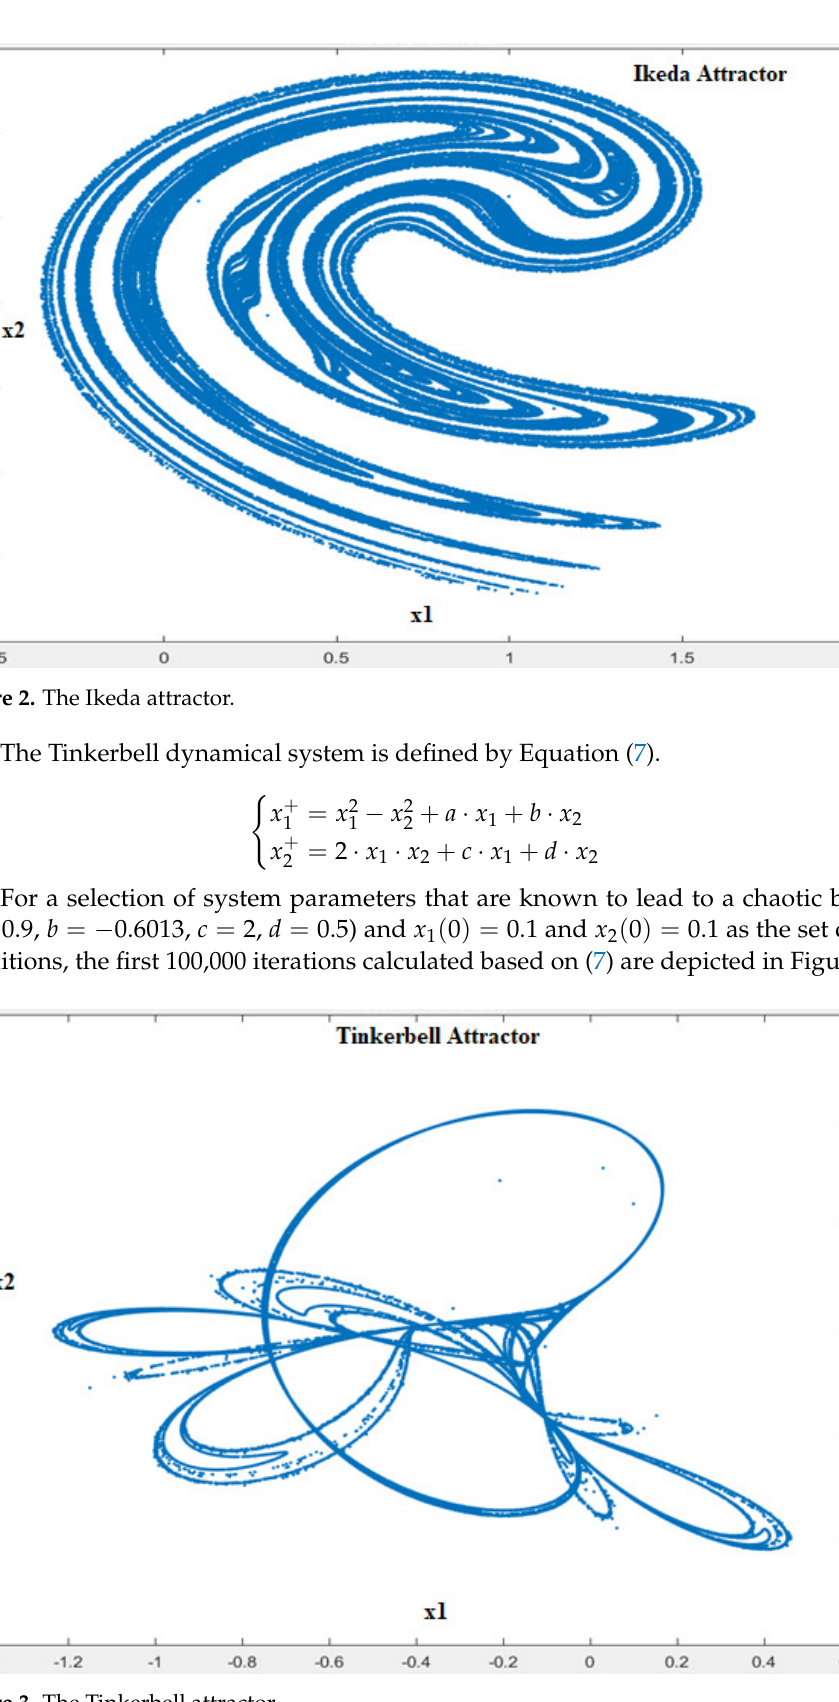
Figure 3. The Tinkerbell